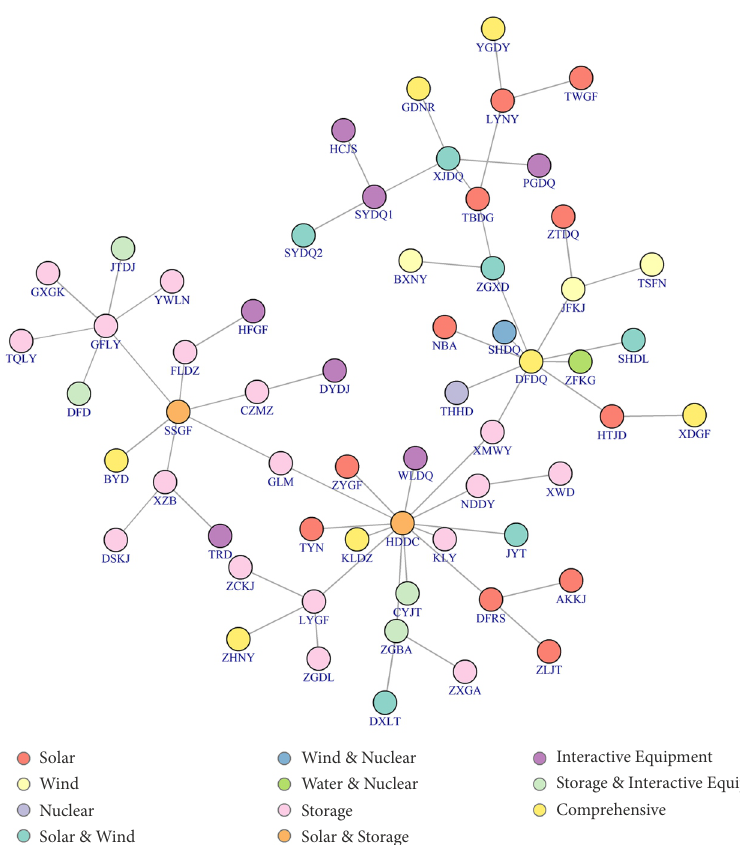
Figure 3. Minimum spanning tree of 60 new energy stocks